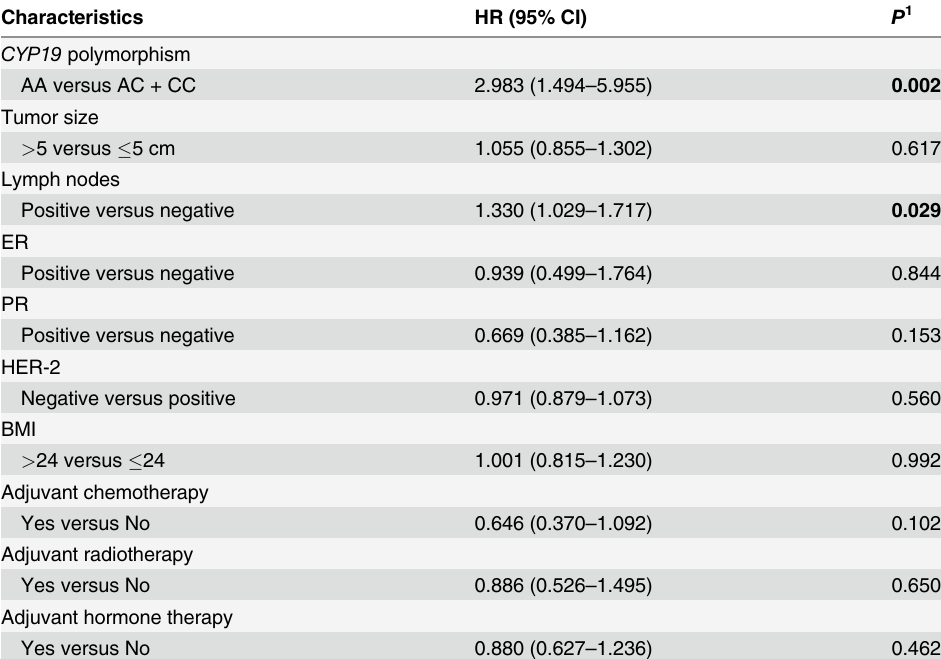
Table 5. Multivariate analysis of prognostic factors and DFS for postmenopausal